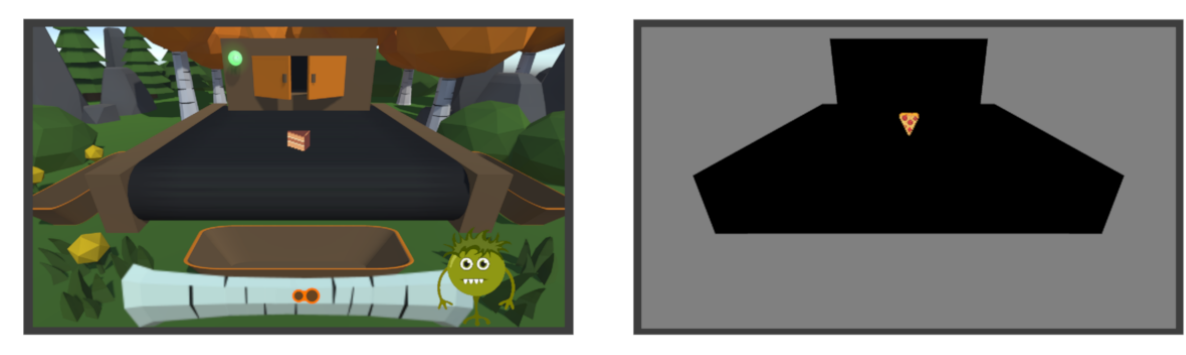
Figure 1. Left: The gamified environment. Stimuli appeared from the warehouse gate at the top of the conveyor belt and subsequently moved down the conveyor belt. The score bar and the companion character, Fred, are visible at the bottom of the conveyor belt. In case of correct responses, the score marker moved to the right; in case of wrong responses, the score marker moved to the left. Right: The nongamified environment. Only the stimuli remain the same as in the gamified version. A black shape covers the area covered by the conveyor belt and the warehouse gate. The forest environment is replaced by a grey